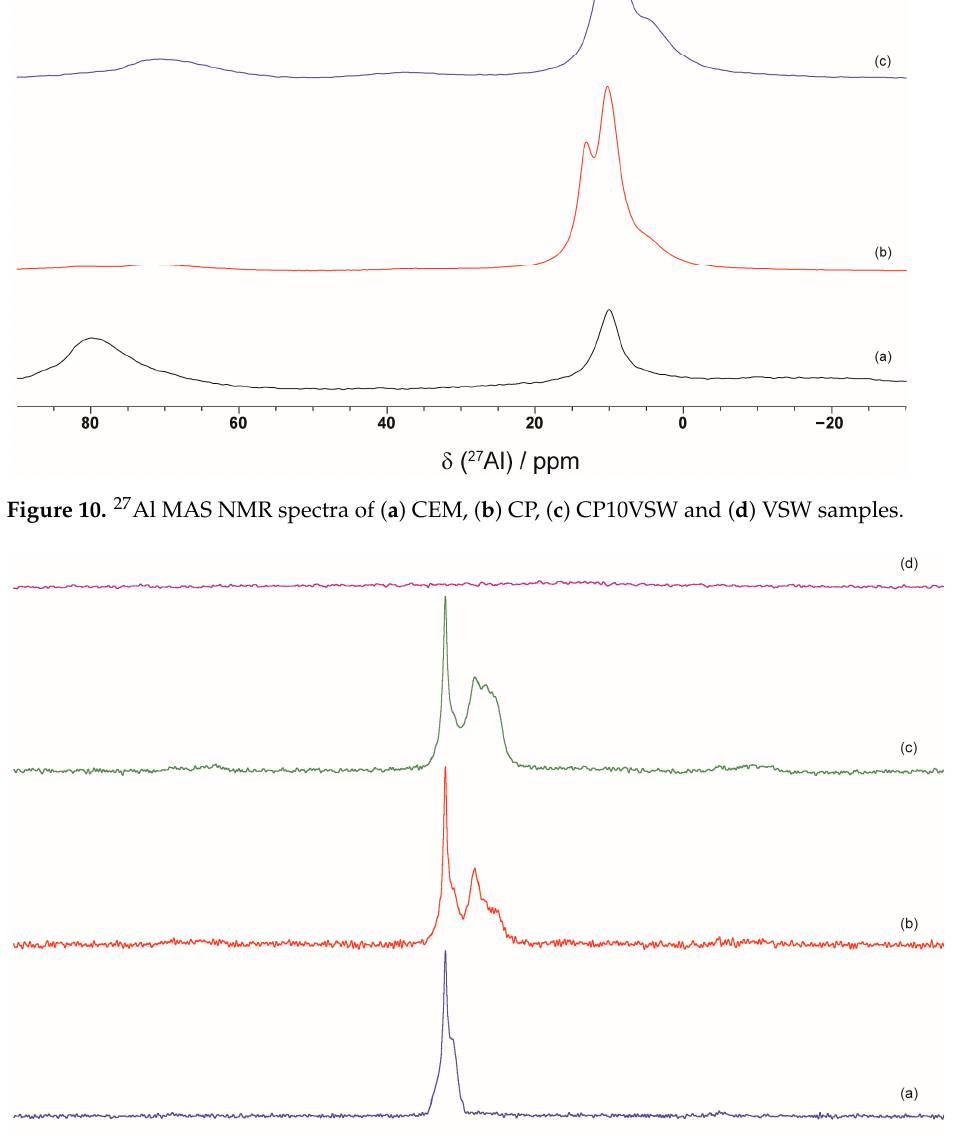
Figure 10. 27 Al MAS NMR spectra of ( a ) CEM, ( b ) CP, ( c ) CP10VSW and ( d ) VSW samples.